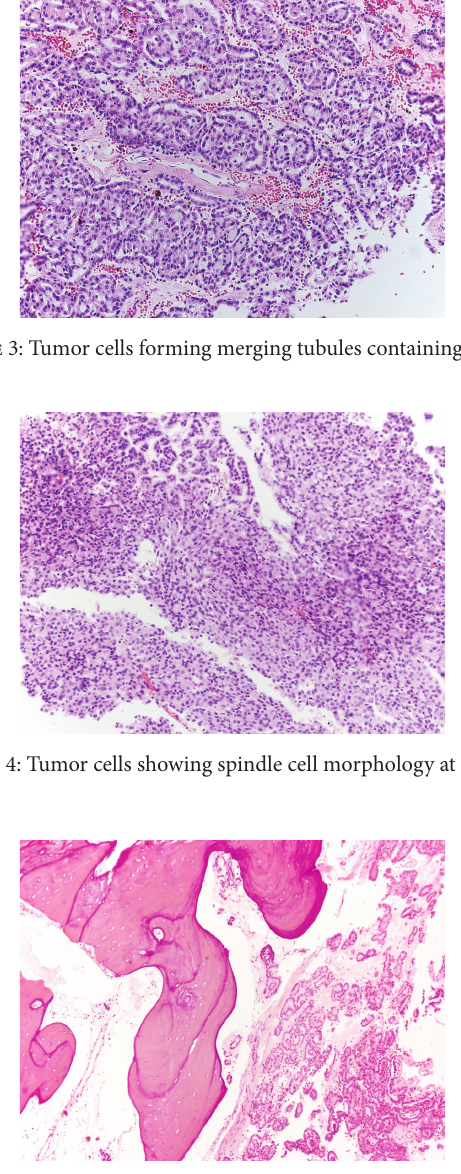
Figure 5: Bone trabeculae are seen adjacent to tumor